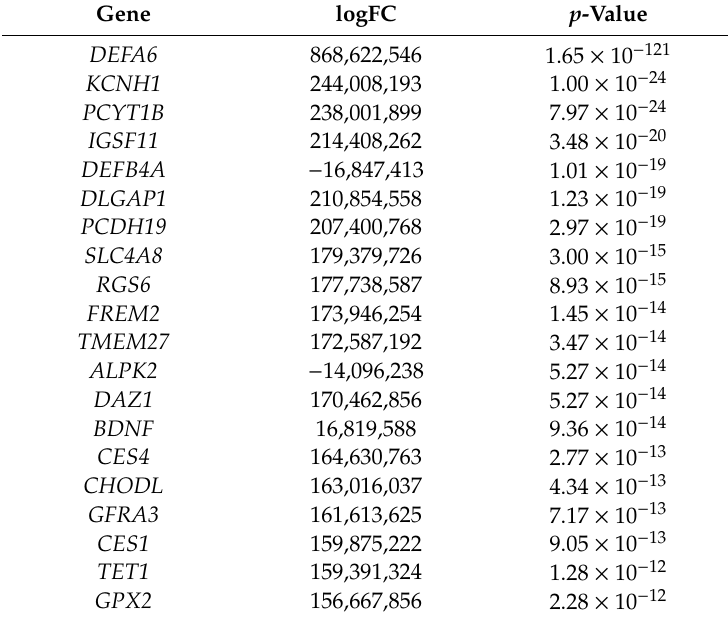
Table 3. 20 most relevant DEGs exclusively in hypopharynx tumour samples compared with normal tissue.